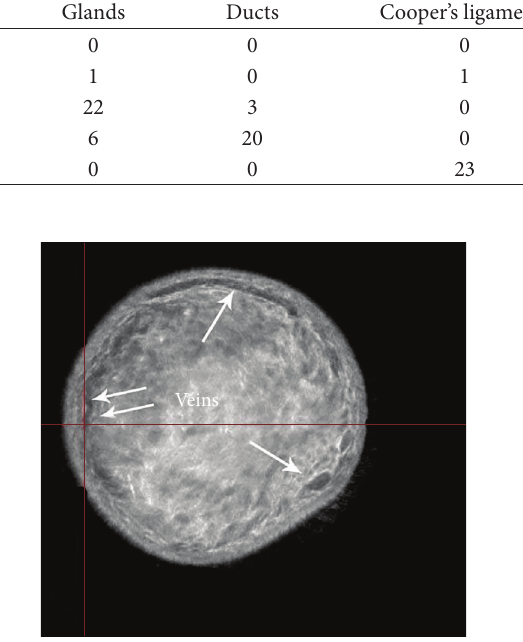
Figure 4: Reflection image of the breast showing superficial veins in cross